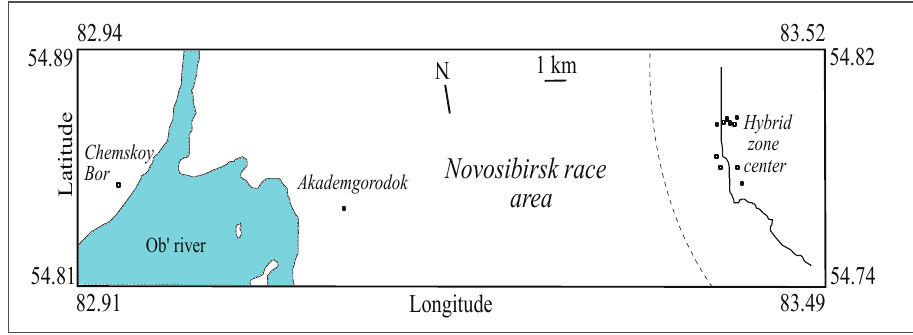
Figure 1. Location of sampling sites. Dotted line marks limits of introgression of the Tomsk autosomes complement; firm curved line determines the centre of the hybrid zone according to Polyakov et al.